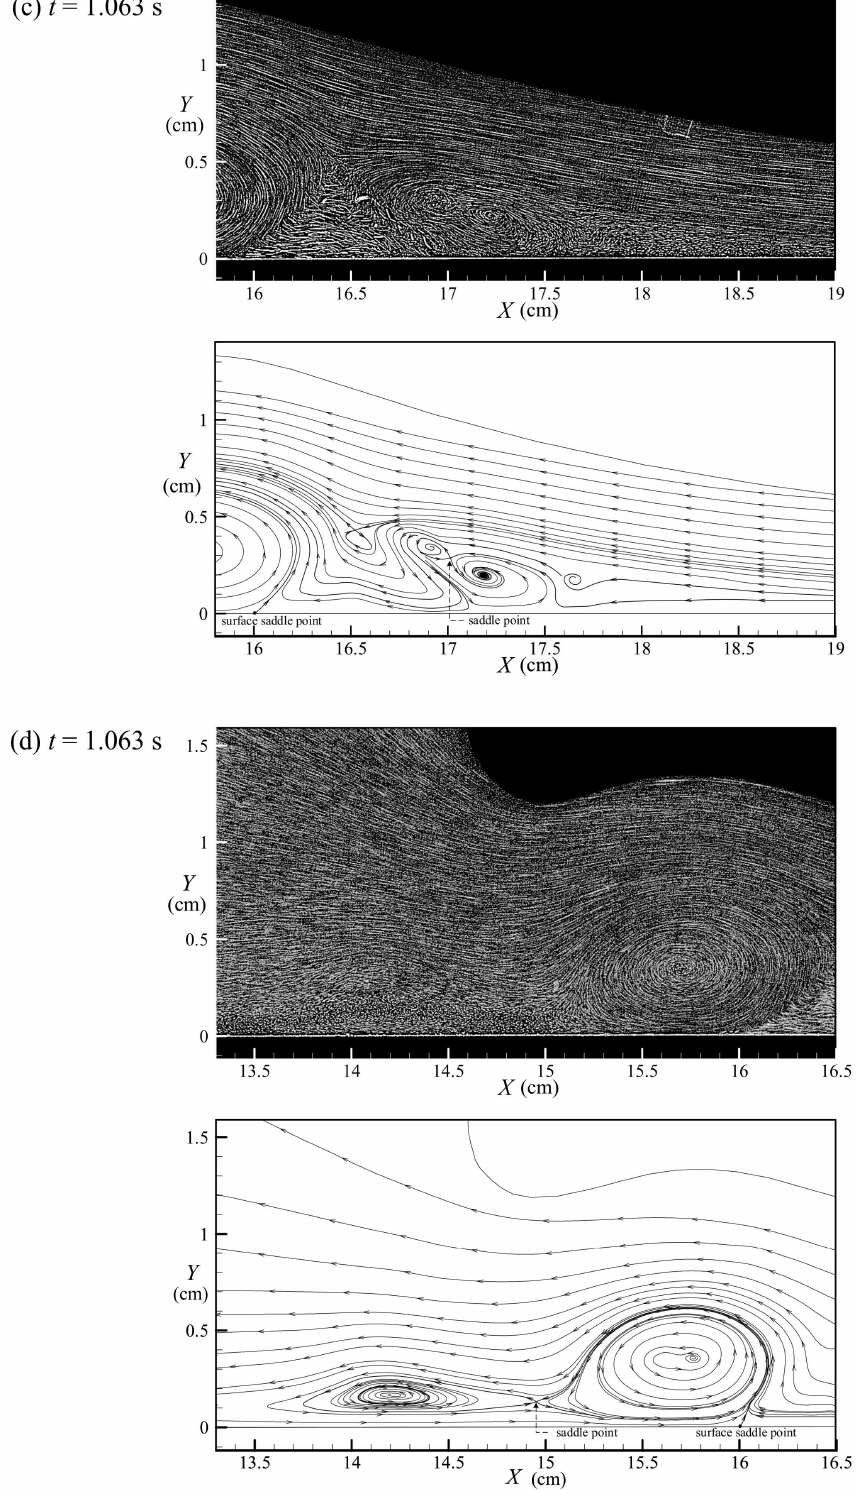
Figure 15. Visualized image (on top panel) and streamlined pattern (on bottom panel) obtained at ( a ) t = 1.017 s; ( b ) t = 1.048 s; ( c , d ) t = 1.063 s. Note that the range on abscissa in ( d ) is different from that shown in ( a – c ) for Case